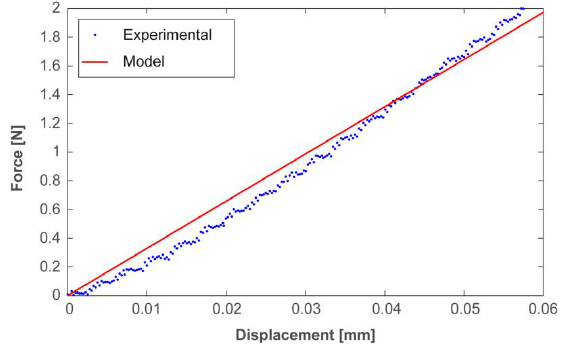
Figure 7. Characterization of the stiffness of the fabricated PDMS test samples and corresponding model calibration. The agreement between experimental (blue dots) and simulated data (red line) confirmed the suitability of the chosen model parameters.